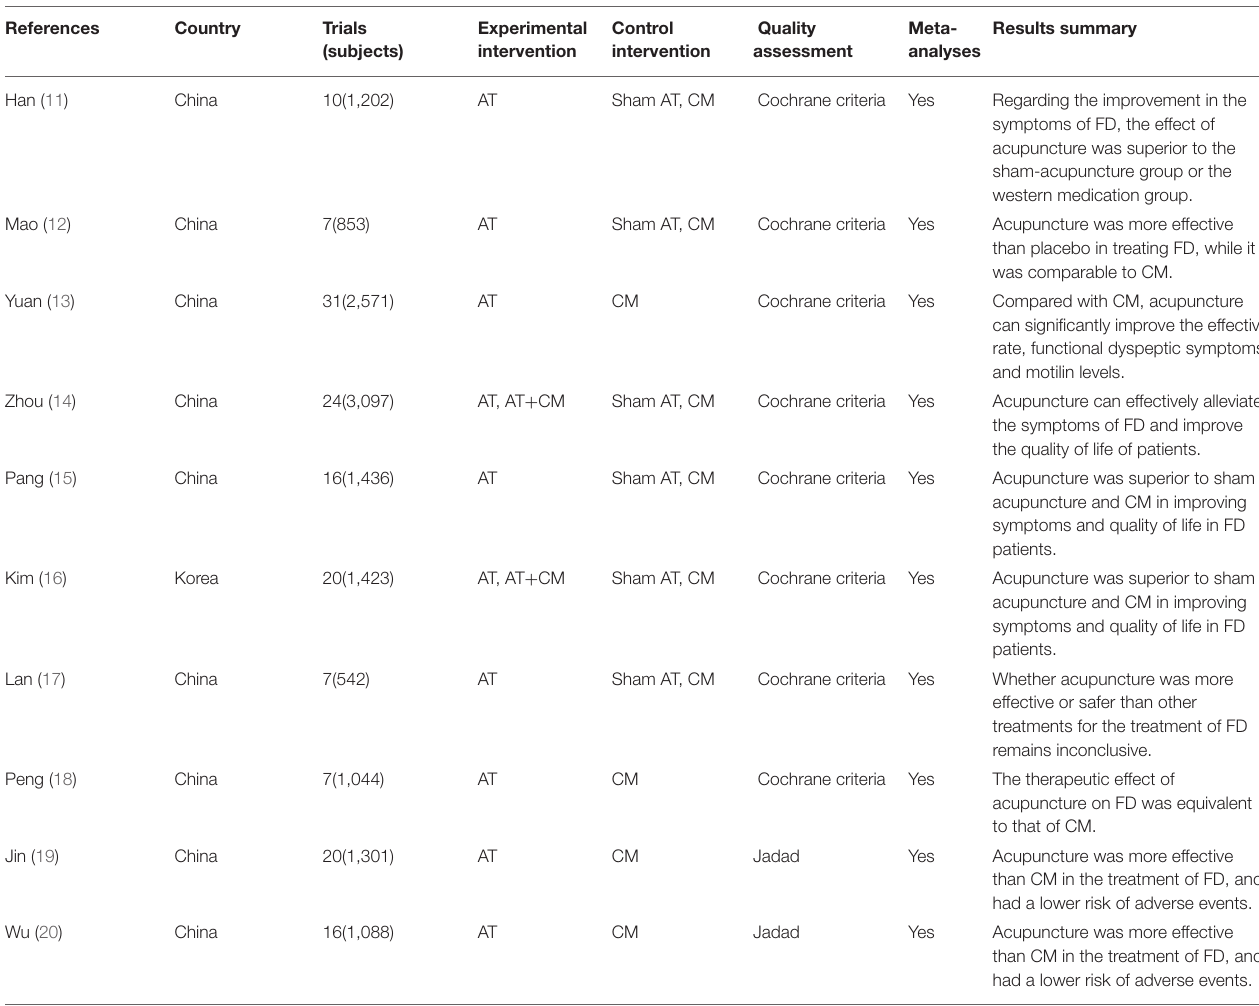
TABLE 2 | A description of the